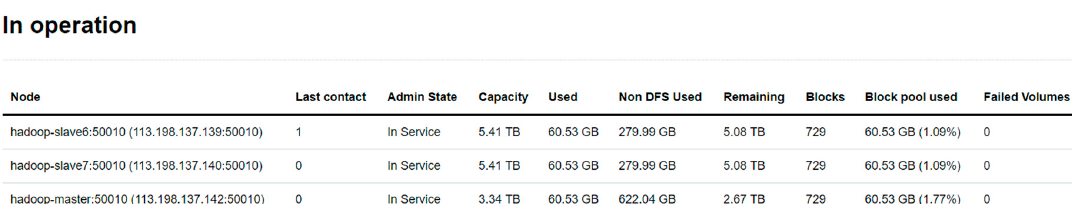
Figure 9. Six programs for grabbing sensing data.